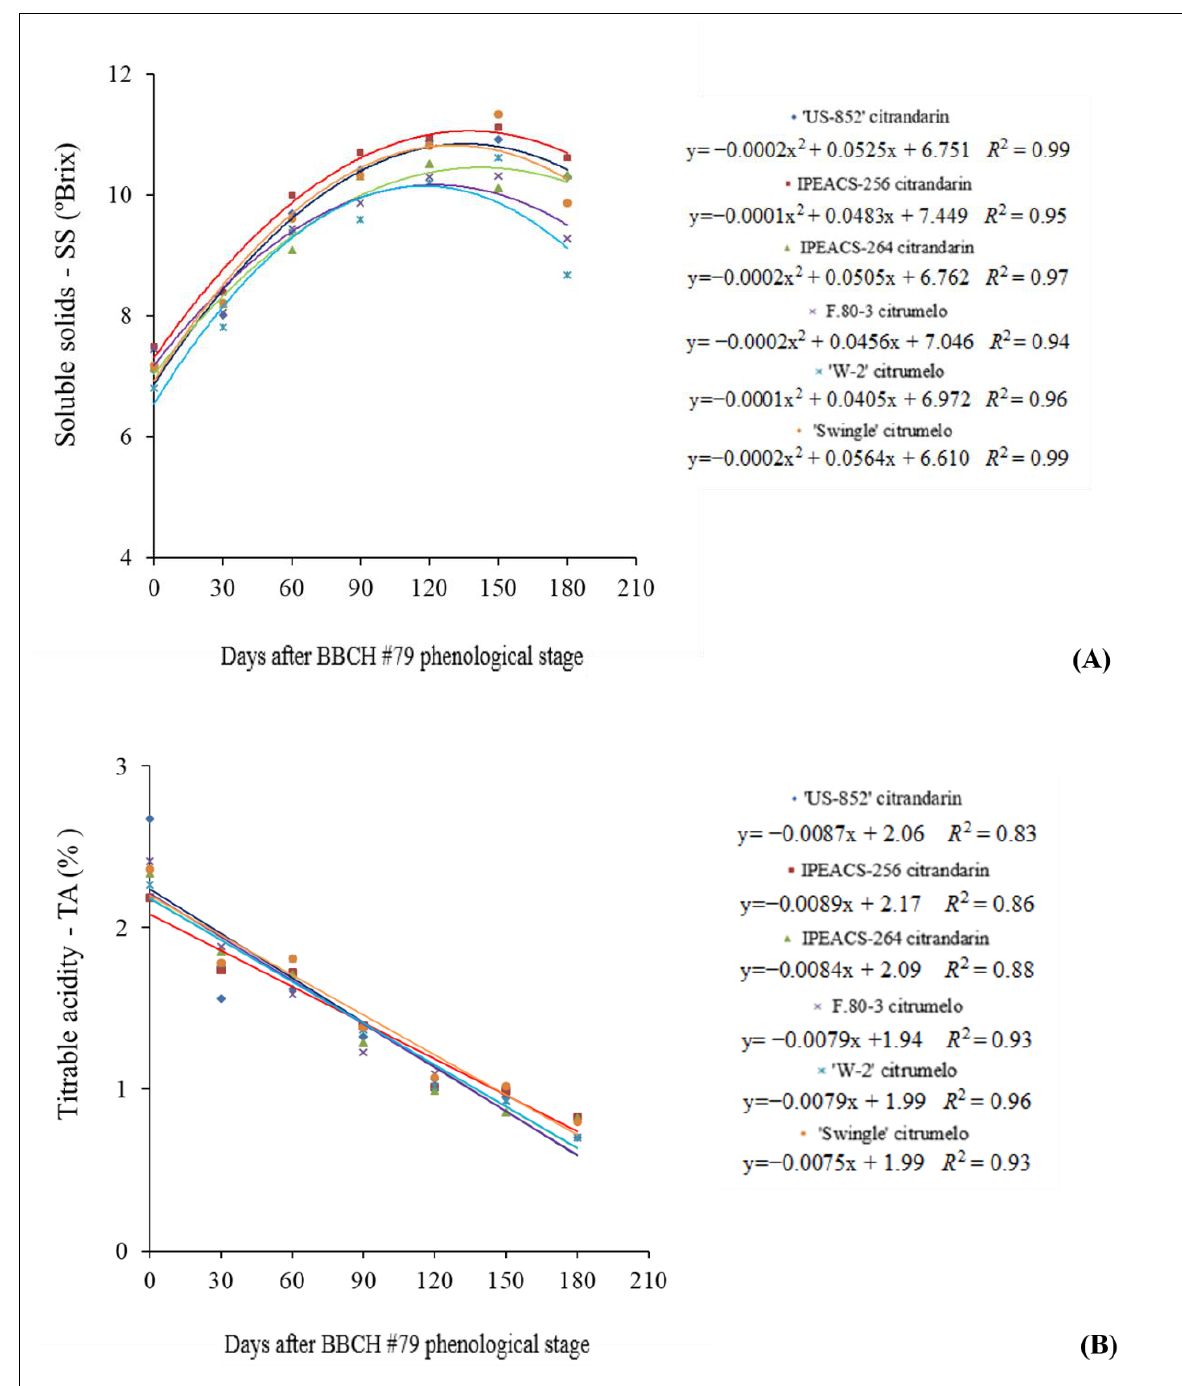
Figure 2. Development of ‘Valencia’ orange fruit ripening when trees are grafted on different ‘Trifoliata’ hybrid rootstocks at Rancho Alegre. ( A ): soluble solids (SS as ◦ Brix); ( B ): titratable acidity (TA as %). Phenological stage BBCH #79 (Meier, 2001), approximately to 200 days after flowering.